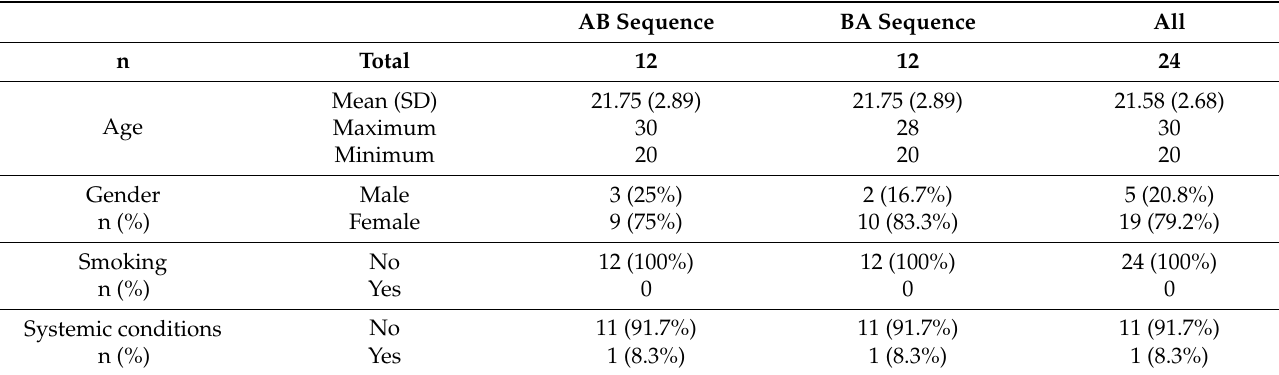
Table 1. Demographic variables, tobacco and systemic conditions for subjects in each sequence of use, and for the whole